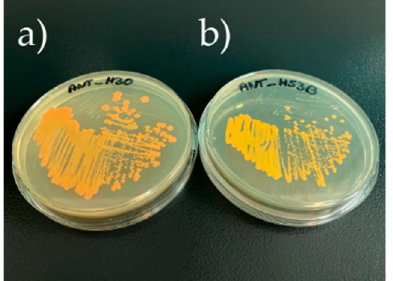
Figure 1. Orange pigmented Antarctic strains analyzed in this study: ( a ) Planococcus sp. ANT_H30 and ( b ) Rhodococcus sp. ANT_H53B. Bacteria were cultivated on agar-solidified lysogeny broth (LB) medium.